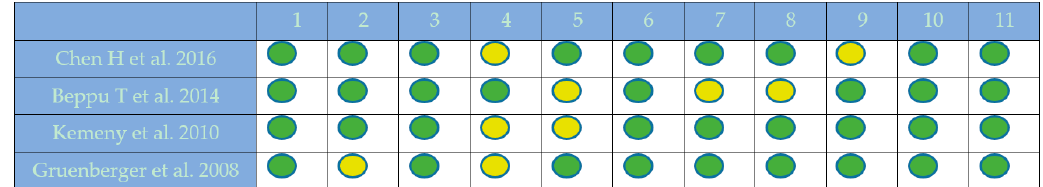
Figure 3. Quality evaluation of clinical trials studies based on CASP checklist. 1. Did the trial address a clearly focused issue? 2. Was the assignment of patients to treatments randomized? 3. Were all of